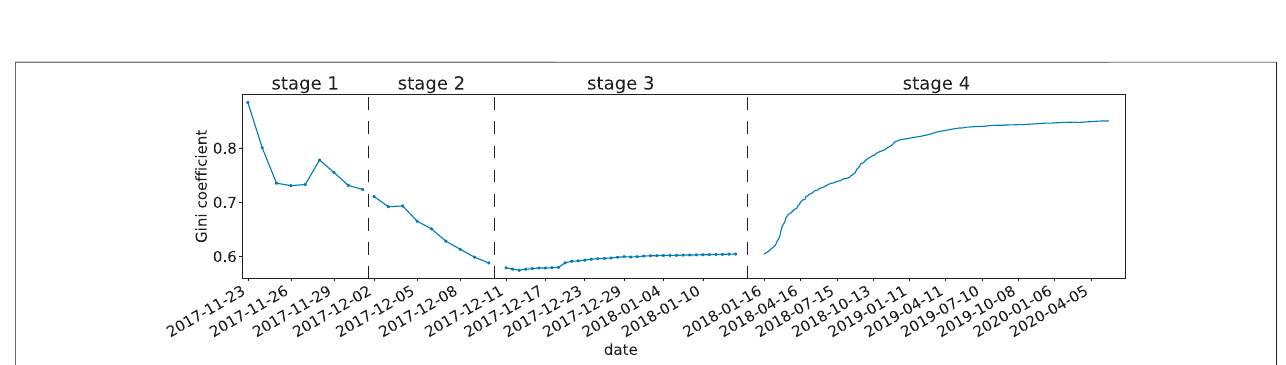
FIGURE12| TheGinicoef fi cientofkittiesownedbyalladdresses.Dottedlinesseparatesthefourstages.The x -axisarere-scaledtobetterillustratetheparameter dynamics in stages 1, 2 and 3.